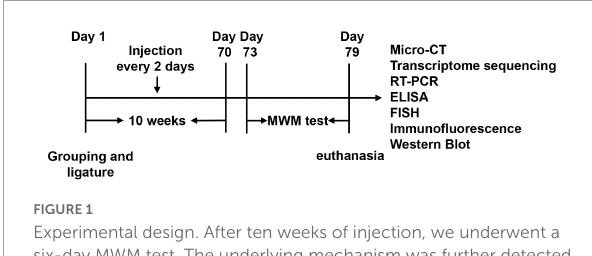
FIGURE1 Experimental design. After ten weeks of injection, we underwent a six-day MWM test. The underlying mechanism was further detected by Micro-CT, transcriptome sequencing, RT-PCR, ELISA, Paraffin-Fluorescence in situ hybridization (FISH), Immunofluorescence, and Western